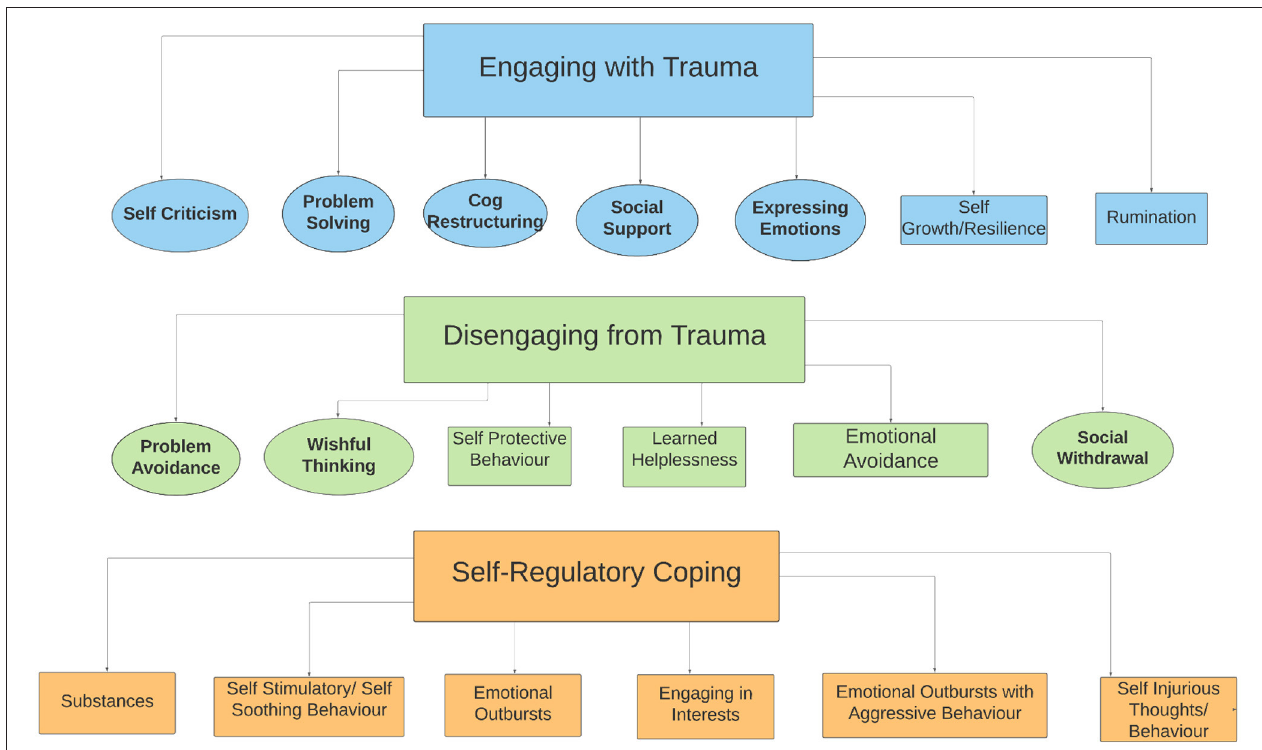
FIGURE 1 | Thematic map of coping strategies. Circles represent deductive codes [originating from Tobin et al. (12) framework]; rectangles represent inductive codes [any codes identified in dataset not outlined in the Tobin et al. (12) framework]; green codes indicate the Disengaging from Trauma theme, blue codes the Engaging with Trauma theme, and orange codes the Self-Regulatory theme. This figure was created in